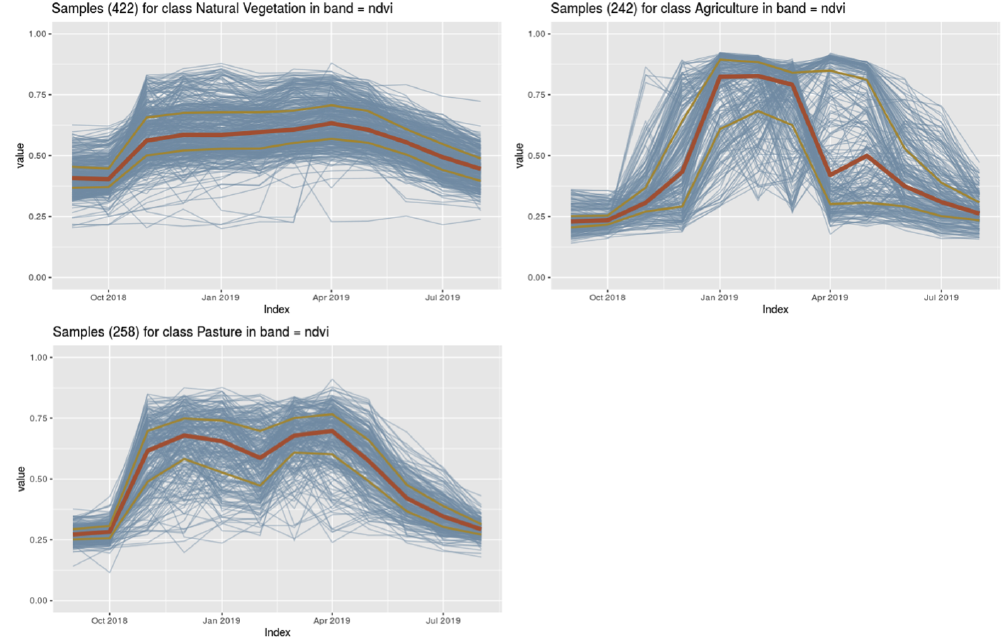
Figure 11. NDVI time series (September of 2018 to August of 2019) extracted from the CBERS-4 data cube of the three land use and cover classes: natural vegetation, pasture, and